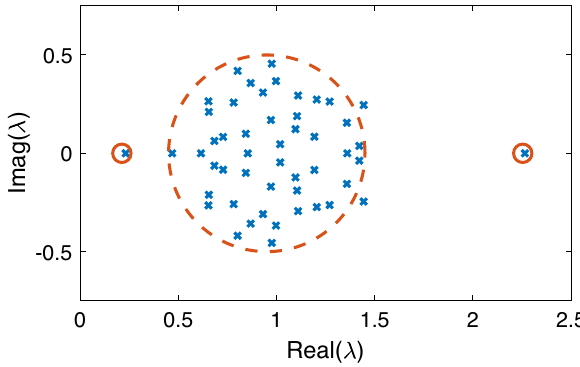
FIG. 7. Spectrum of conditioned β . Crosses: eigenvalues of a matrix β conditioned with the pattern defined by Eqs. (4) and (5), with S ¼ 50 . Dashed line: circle within which β cond should have eigenvalues due to σ A . Small circles: predicted positions of addi- tionaltwo eigenvalues. Other parameters: η 1 … 10 ¼ 3 , η 11 variables, uniformly sampled in [0, 1.5];